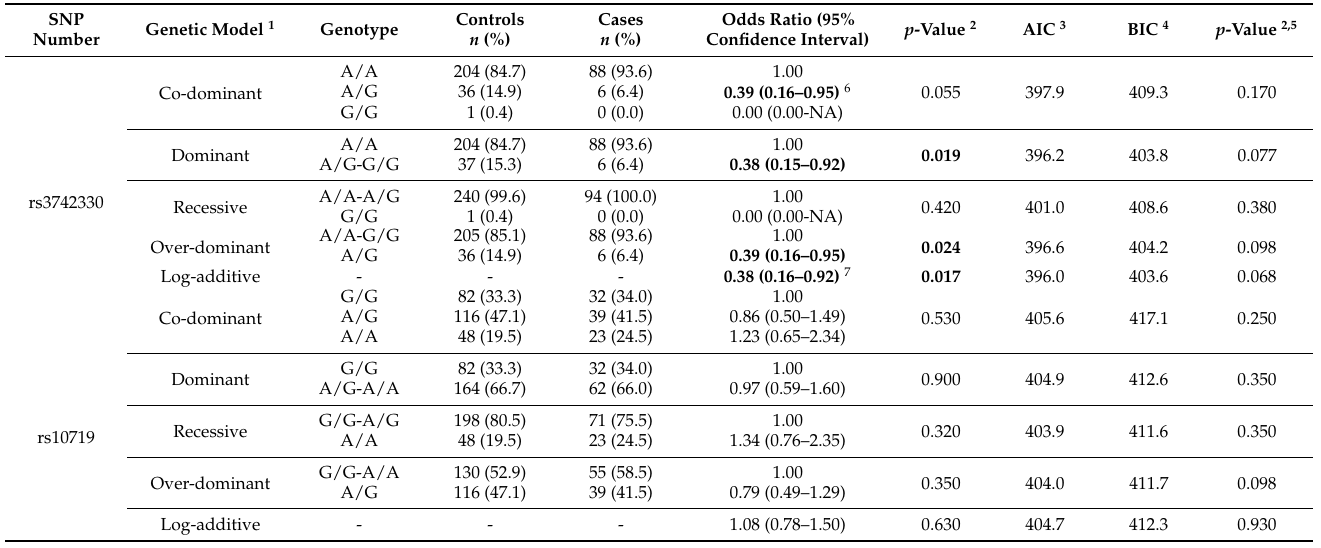
Table 2. Association analysis of polymorphisms rs3742330 in DICER1 and rs10719 in DROSHA with the risk of pseudoexfoliation glaucoma cases compared to controls under different genetic